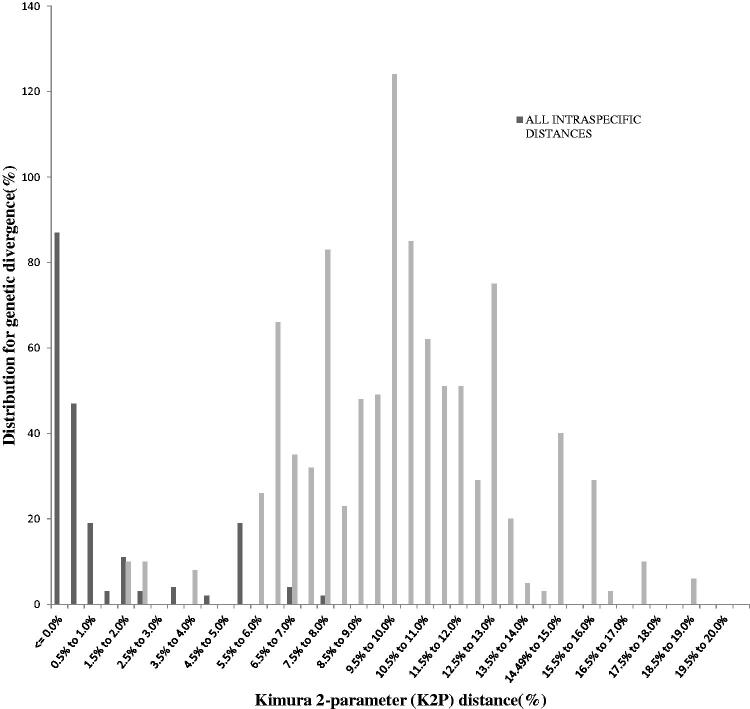
Revised barcoding gap between interspecific and intraspecific divergences among samples for species identification based on the phylogenetic gene.